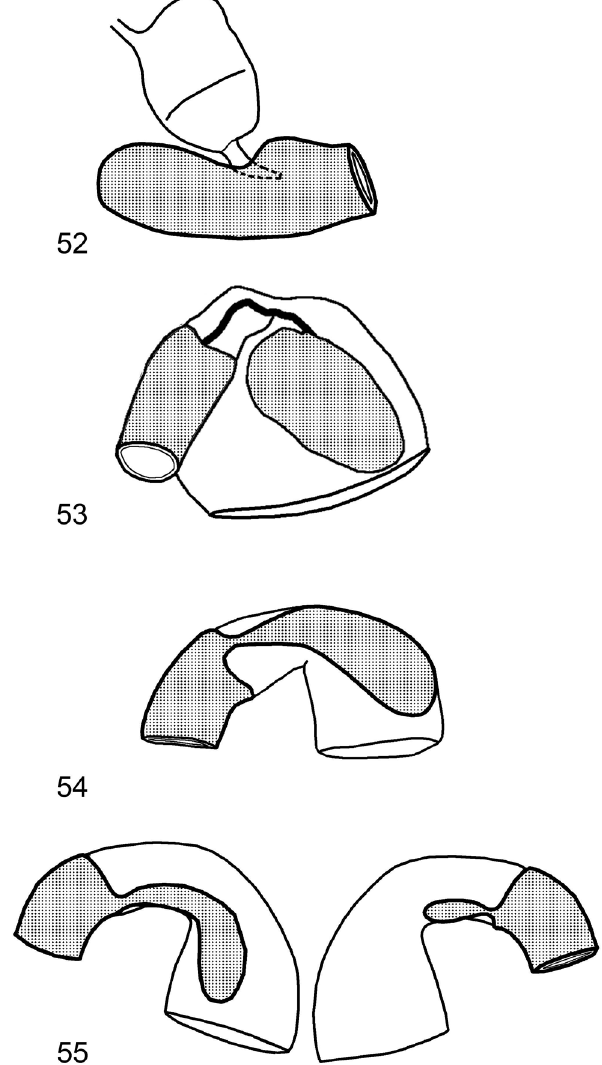
Figs 52–55. Details of gut structures in Syntermitinae species.